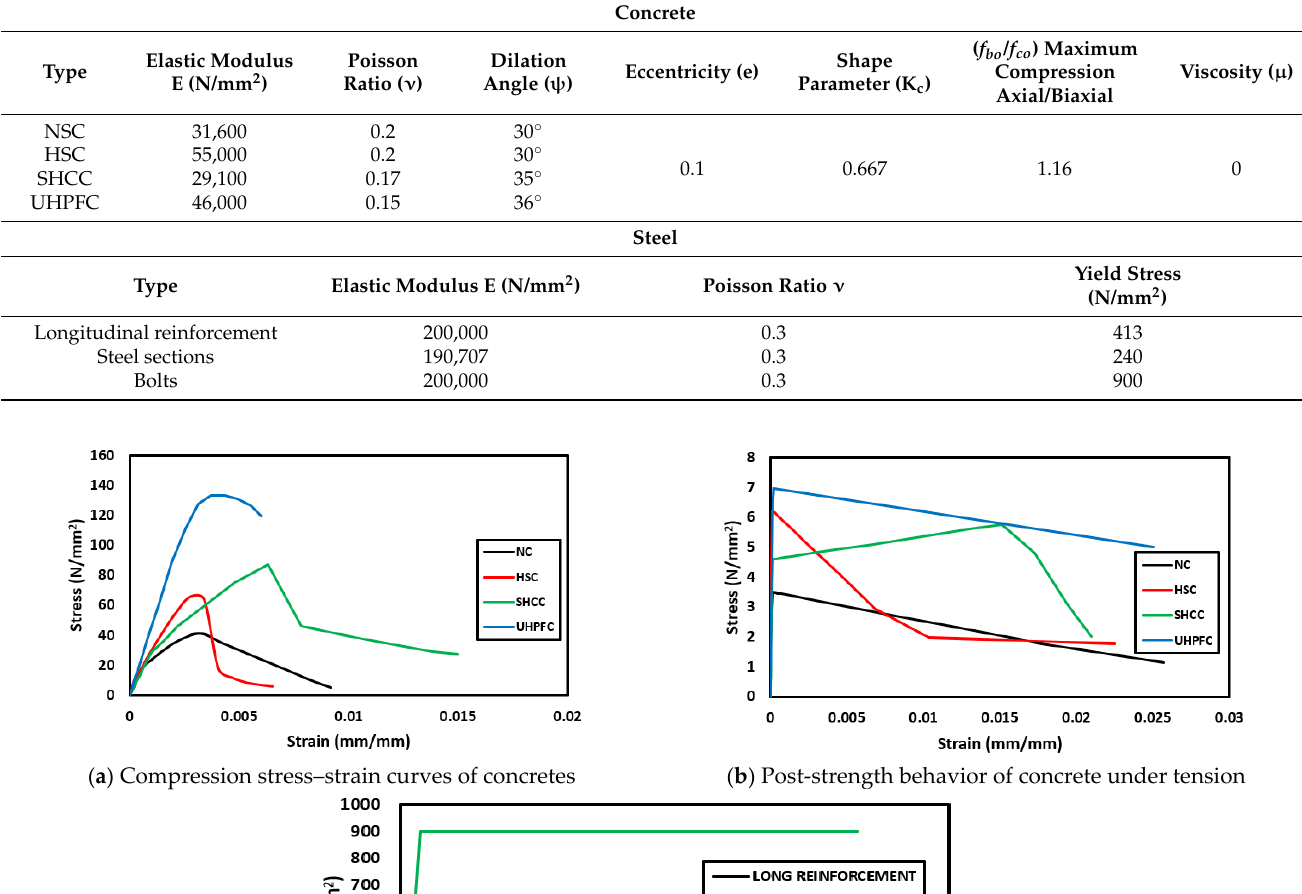
Figure 17. Model of NC-OT slab. Table 4. CDP parameters used for concretes, mechanical properties of steel bar meshes, and steel skeleton.